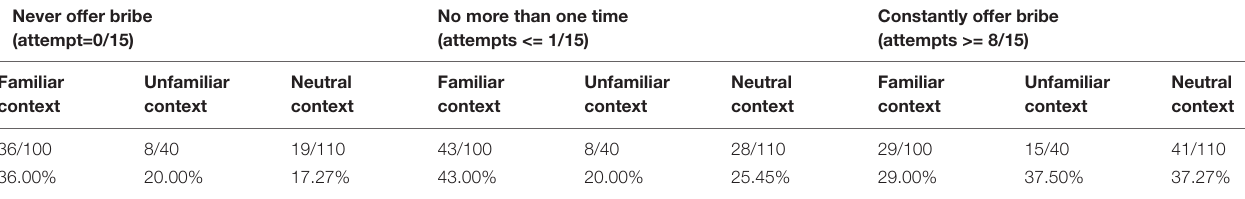
Table 5 | The frequency of the Player 2s’ (potential bribees) unethical decisions. Never violate the rule (attempt = 0/15)